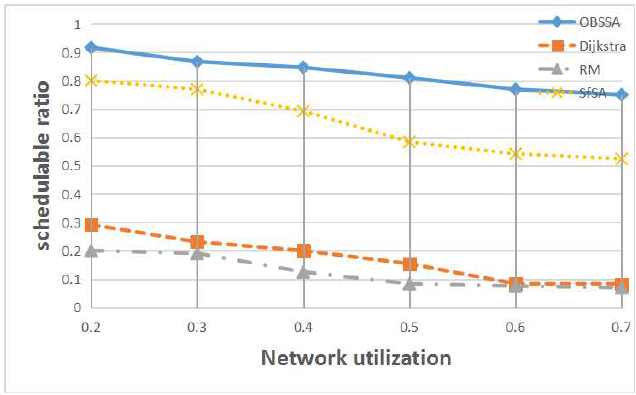
Figure 11. The relationship between the schedulability ratio and the network